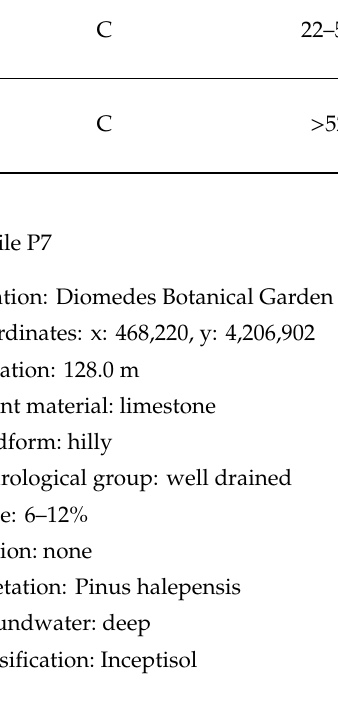
Table A15. Profile P7 horizons